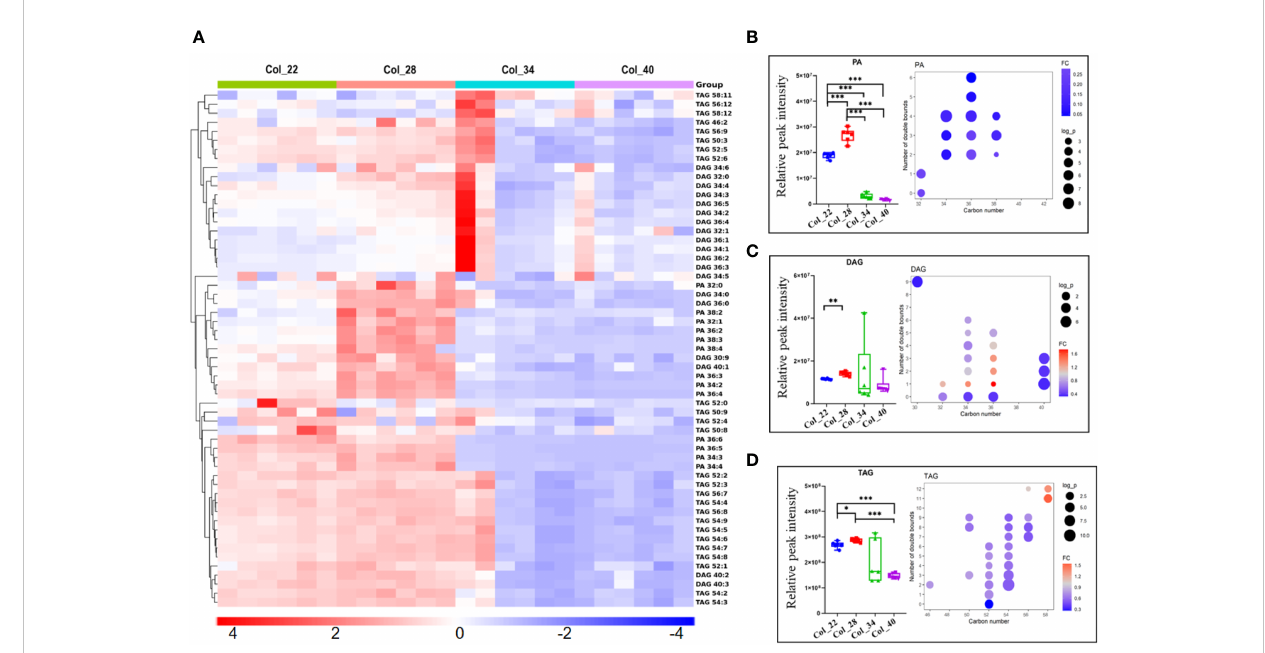
FIGURE 4 Comparative analysis of phosphatidic acid and glycerol lipids for Arabidopsis seed germination/seedling growth under four temperature conditions. (A) Heatmap showing Z score scaled the alteration of phosphatidic acid and glycerol lipids at moderate (22°C, 28°C) and the extreme high temperatures (34°C, 40°C). The relative enrichment of each lipid in different samples were arranged in rows, and the relative levels of all lipids in each sample were distributed in columns. The grids in heatmap represented lipids, and shades of color represented relative level of lipids. Red and blue colors indicate an increase and a decrease of lipid level, respectively, and white color means no change. Col_22 means seeds germinated at 22°C, Col_28 means seeds germinated at 28°C, Col_34 means seeds germinated at 34°C, Col_40 means seeds germinated at 40°C. (B – D) Relative classed level of phosphatidic acid and glycerol lipids (small fi gure on the left of block diagram) and levels of different molecular species (small fi gure on the right of block diagram) under four temperature conditions. The FC difference was calculated as extreme high temperature group vs. moderate temperature group. Phospholipids are shown as PA (B) , DAG (C) and TAG (D) . Phosphatidic acid (PA), Diacylglycerol (DAG), Triacylglycerol (TAG). Data are presented as mean ± SD. * P < 0.05, ** P < 0.01, *** P <